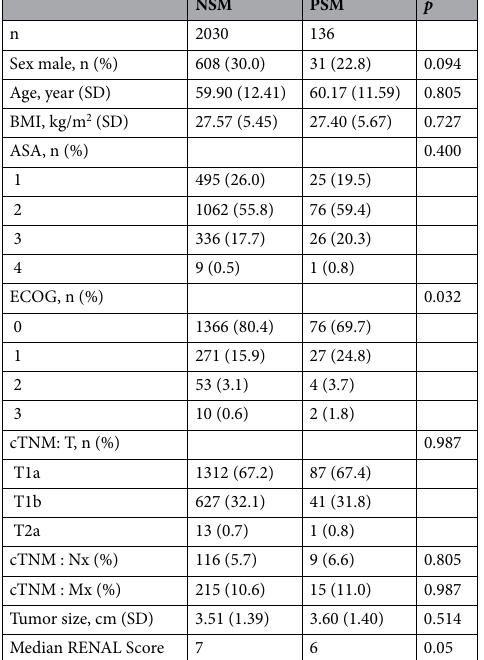
Table 1. Patients Characteristics at time of RAPN. NSM negative surgical margins, PSM positive surgical margins, BMI body mass index.